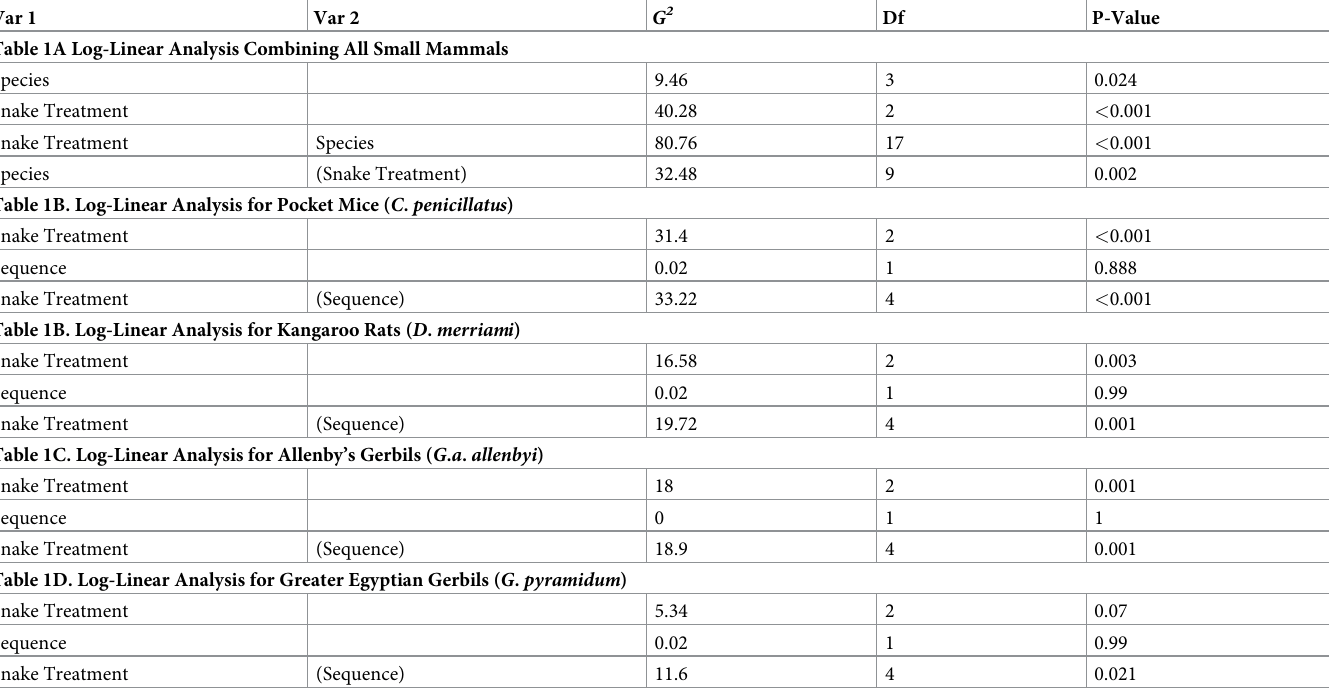
Table 1. Log-Linear Analyses (multi-way contingency tabulations) for all species combined (A) and each species separately (B-E) comparing the cumulative number of trays foraged to unforaged ones as the measure of comparison. Table 1A Log-Linear Analysis Combining All Small Mammals